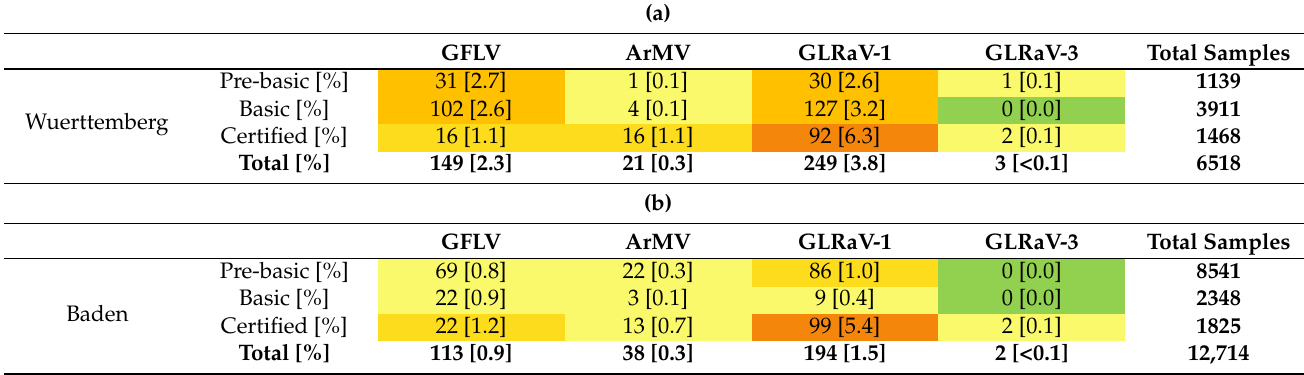
Table 2. GFLV and GLRaV-1 occur more frequently in Wuerttemberg than in Baden. Listed are results of ELISA tests on scion propagation material from 2009–2020, separated by the regions Wuerttemberg (a) and Baden (b). The table shows the amount of positive tested samples for each virus and the percentage relative to the total number of pooled samples (square brackets). Individual viruses are color coded depending on their incidences: 0.0% (green); 0.1–0.9% (pale yellow); 1.0–1.9% (yellow); 2.0–4.9% (dark yellow); 5.0–9.9% (orange); over 10.0% (dark orange). (a) GFLV ArMV GLRaV-1